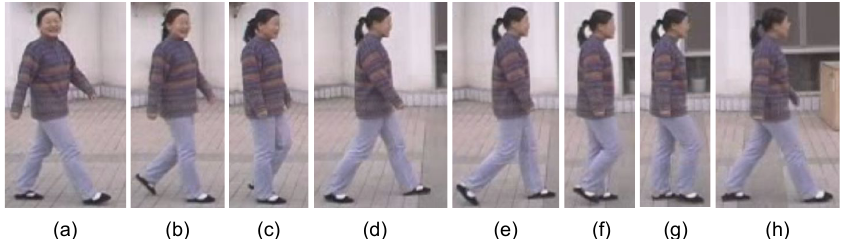
Figure 13. Gait example from CASIA-A dataset. ( a ) Initial contact, ( b ) Loading response, ( c ) Mid- stand, ( d ) Terminal stance, ( e ) Pre-swing, ( f ) Initial swing, ( g ) Mid-swing, ( h ) Terminal swing. The stance phase is defined from ( a ) to ( e ). The swing phase is from ( f ) to ( h